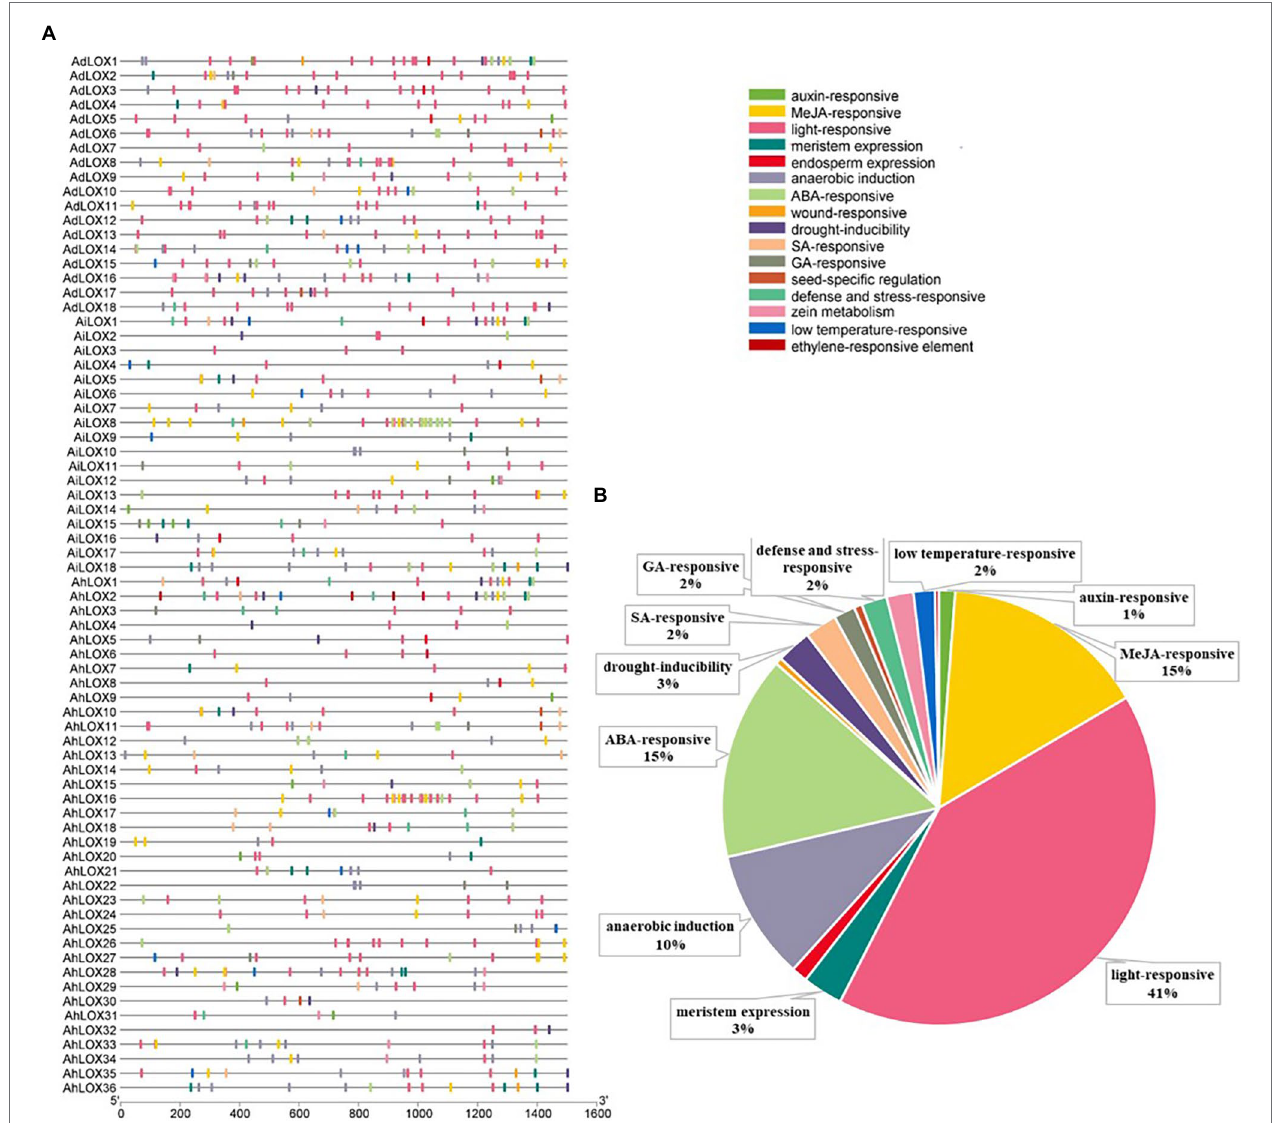
FIGURE 4 | Distribution of cis-acting regulatory elements in the peanut LOX gene promoters. (A) The distribution of cis-acting elements in the promoter of each peanut LOX . (B) The ratios of different functional cis-acting elements are shown in the form of pie